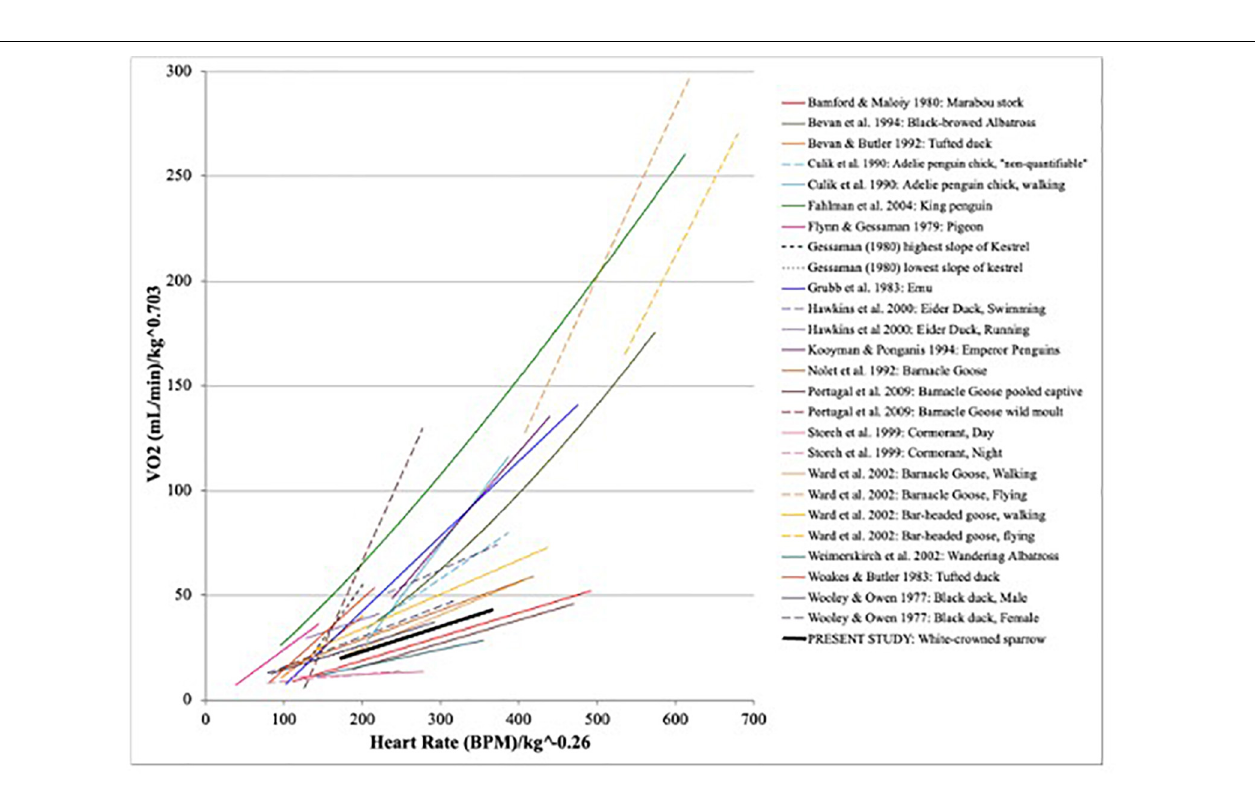
Frontiers in Ecology and Evolution |